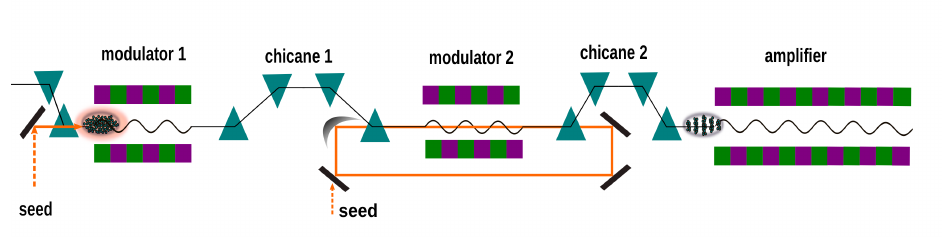
Figure 3. In an oscillator-based EEHG scheme, one or two optical cavities can be attached. In this figure, the first modulation occurs with a conventional external seed laser, while the second energy modulation is achieved by employing an optical cavity around the second modulator. The optical cavity is fed by a seed laser and maintains its properties in order to seed consecutive electron